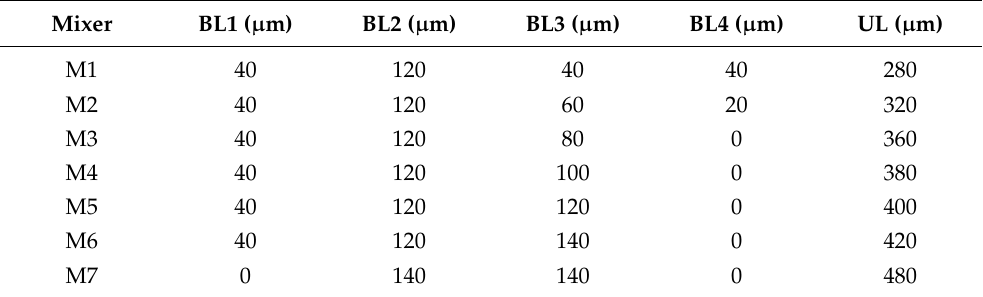
Table 2. Geometric dimensions of the obstacle structures of six different types of mixing units integrated into the asymmetric micromixers (M1–M6) and a serpentine micromixer (M7) with a symmetric mixing unit (Figure